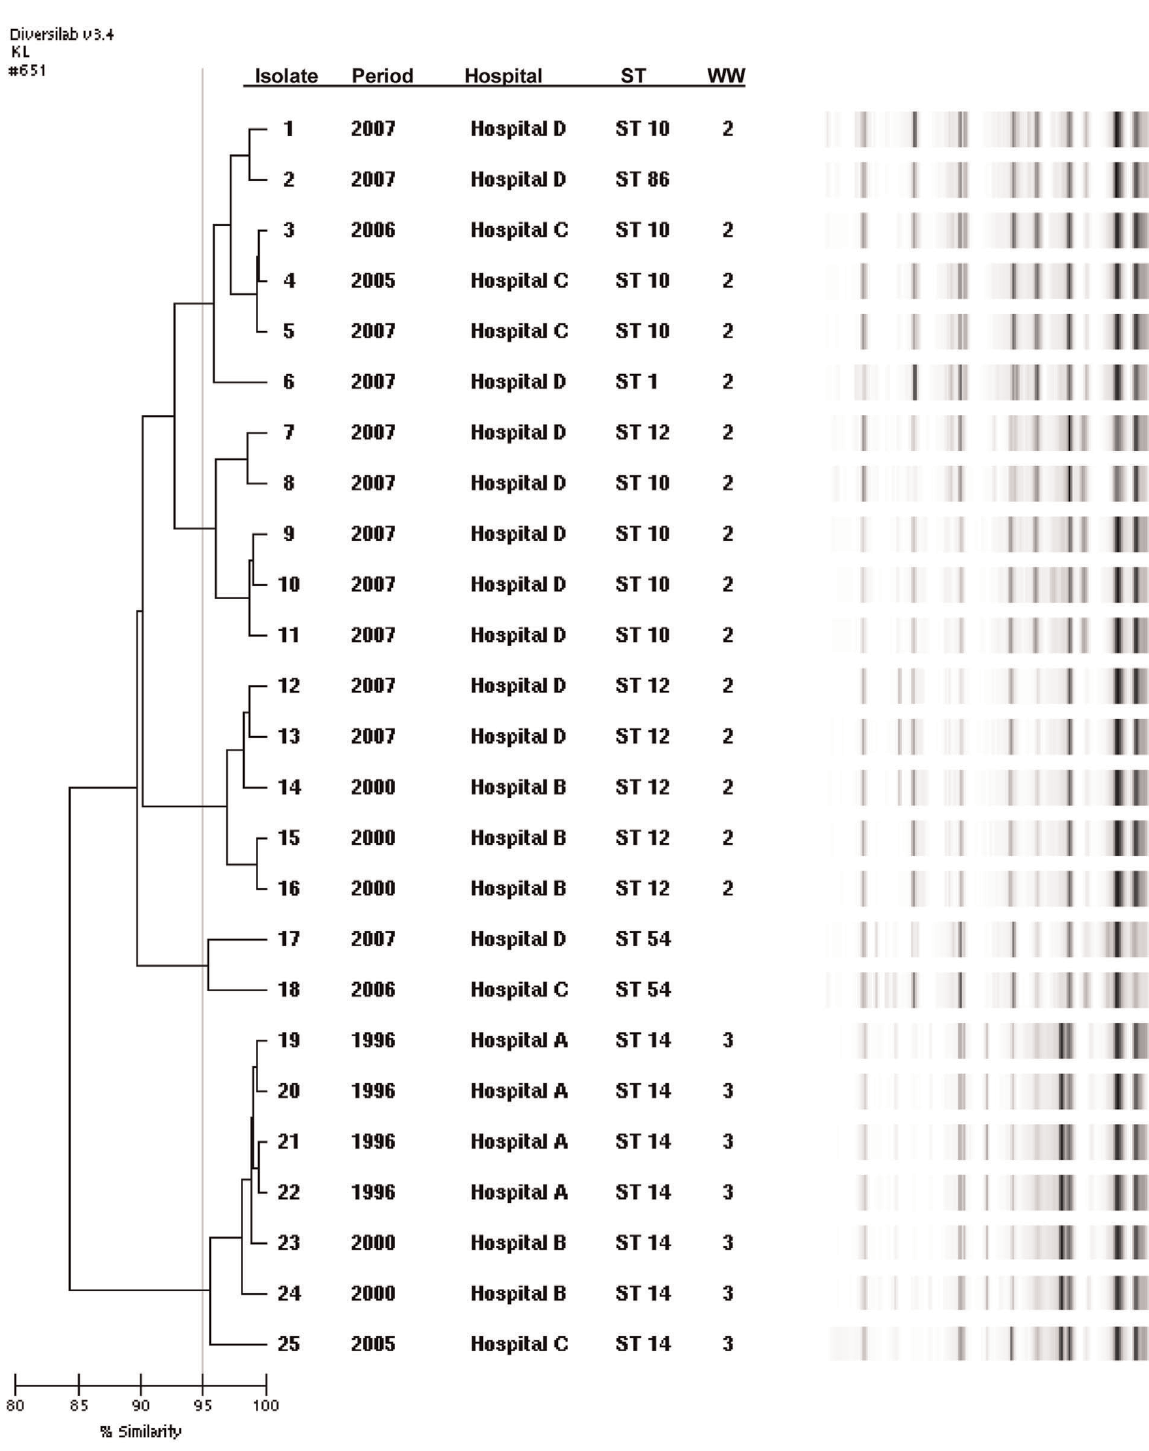
29 strain types, depending on the typing method used. Although